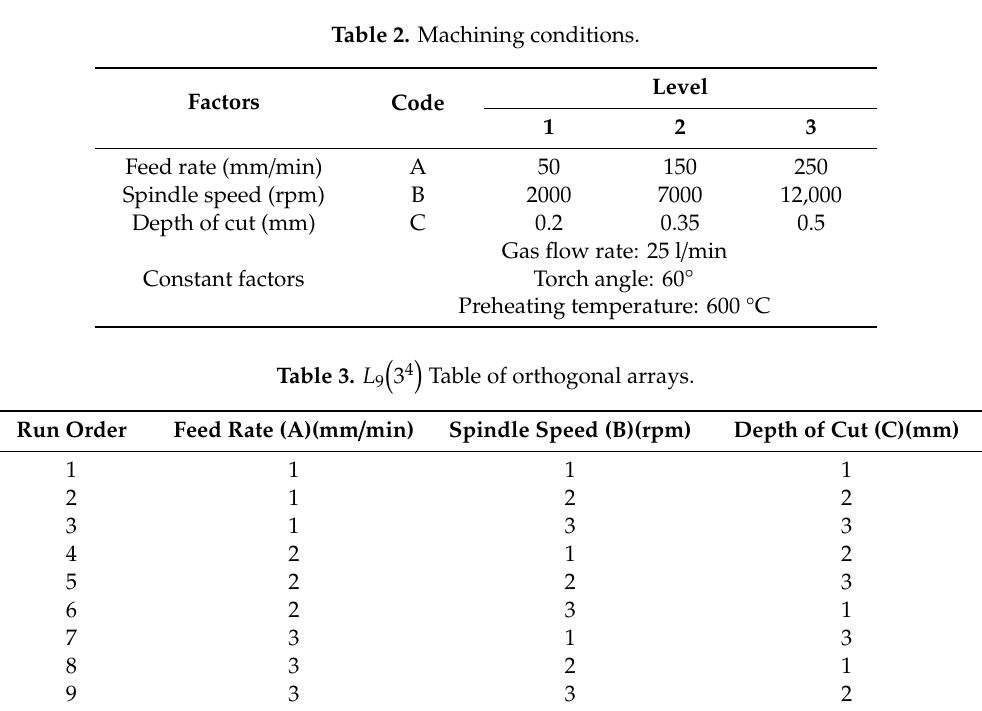
Table 2. Machining conditions.